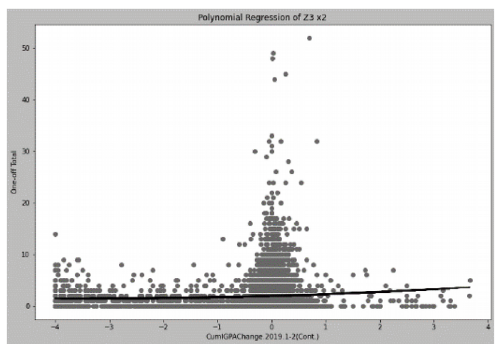
Figure 12. Polynomial Regression of Z3 x2 in Finding